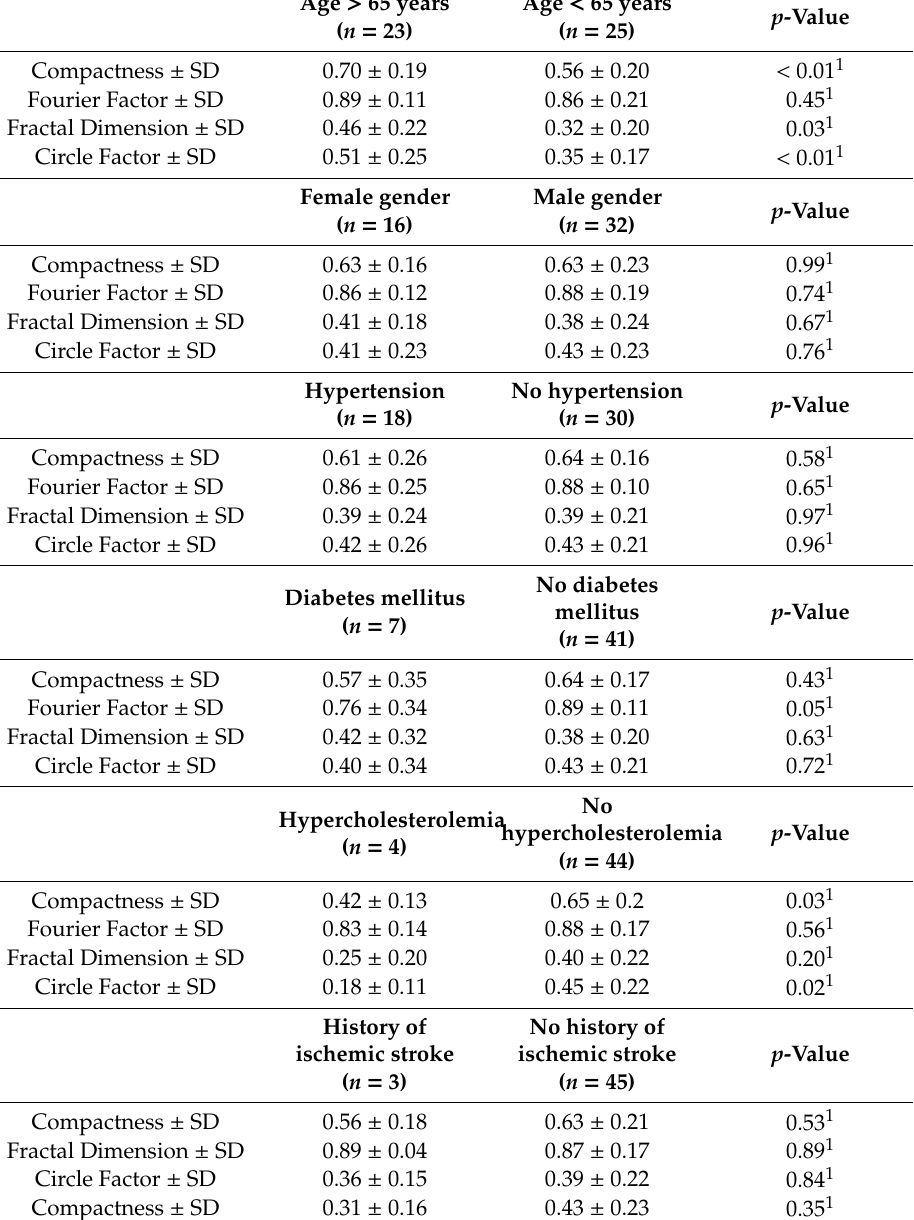
Table 1. Association of comorbidities with ICH shape descriptors. SD—standard